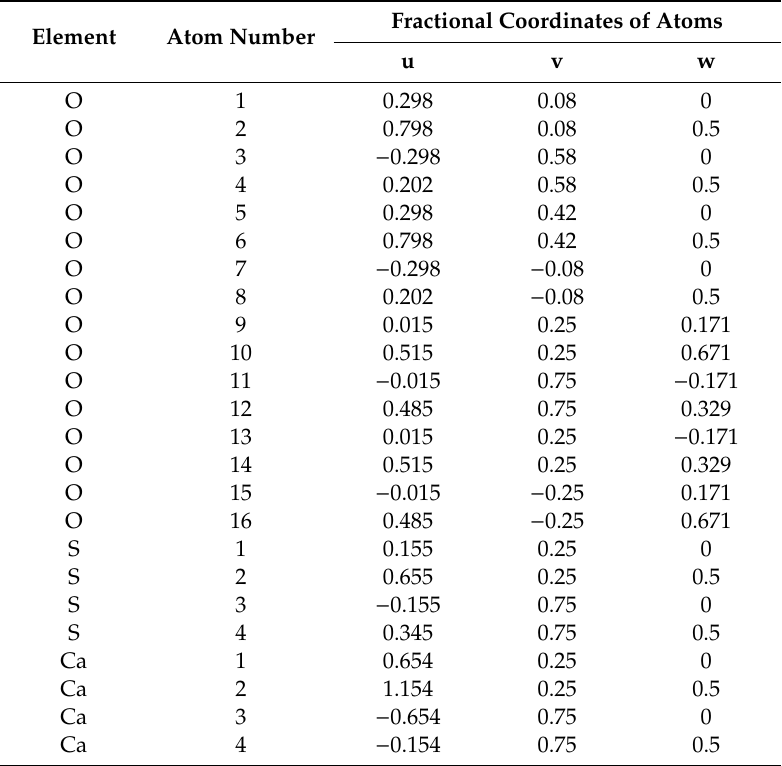
Table 3. Comparison of lattice parameters of anhydrite (unit: Å ).